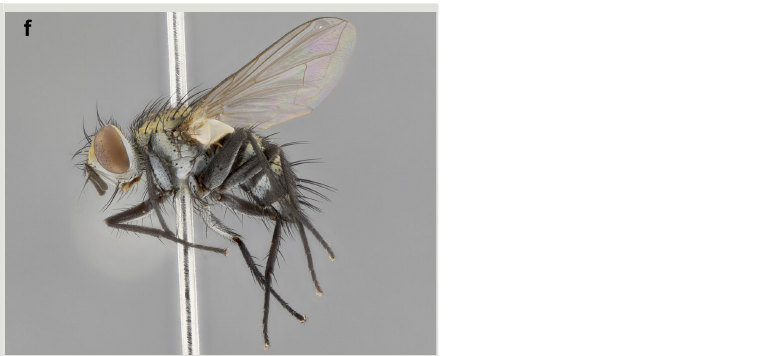
Figure 26. General morphology of Calolydella omissa sp. n. ; a–c : male holotype, voucher n. DHJPAR0016605; d–f : female paratype, voucher n. 06-SRNP-43825.